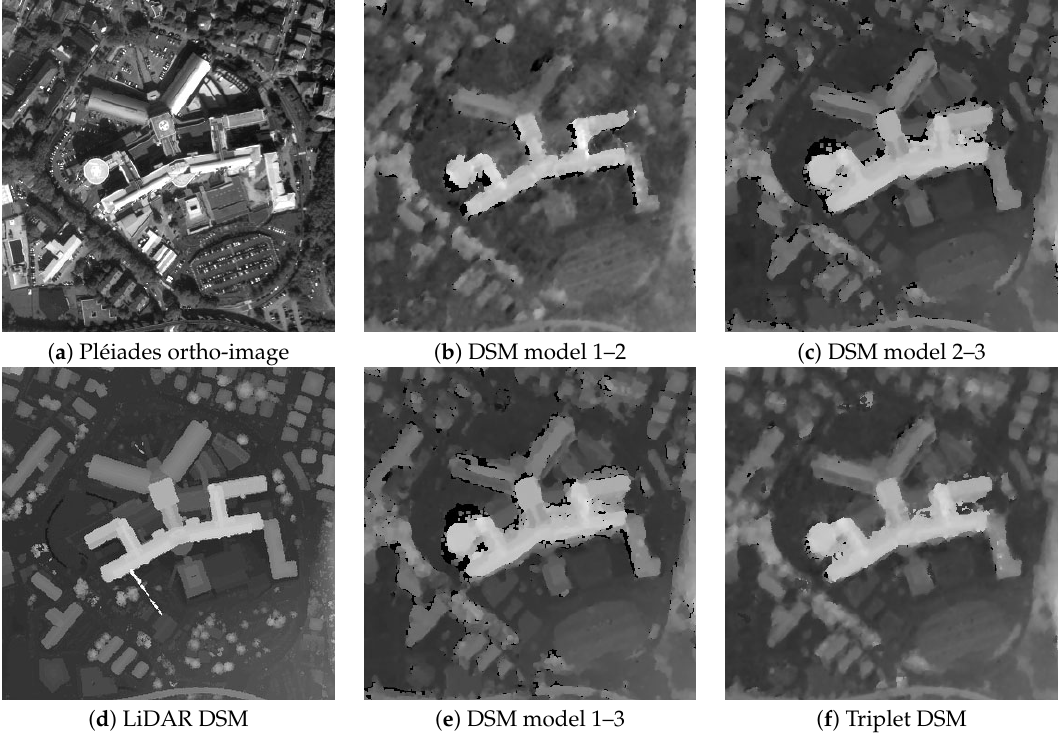
Figure 19. Detail view of a hospital at the Trento test site.